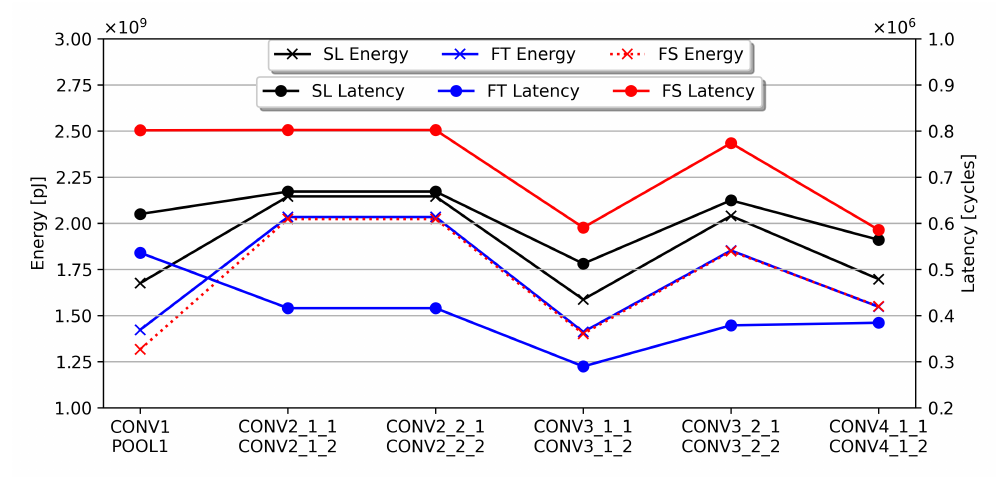
Figure 14. Resnet18 single layer (SL) vs. temporal fusion (FT) vs. spatial fusion (FS) with HW config. 1.